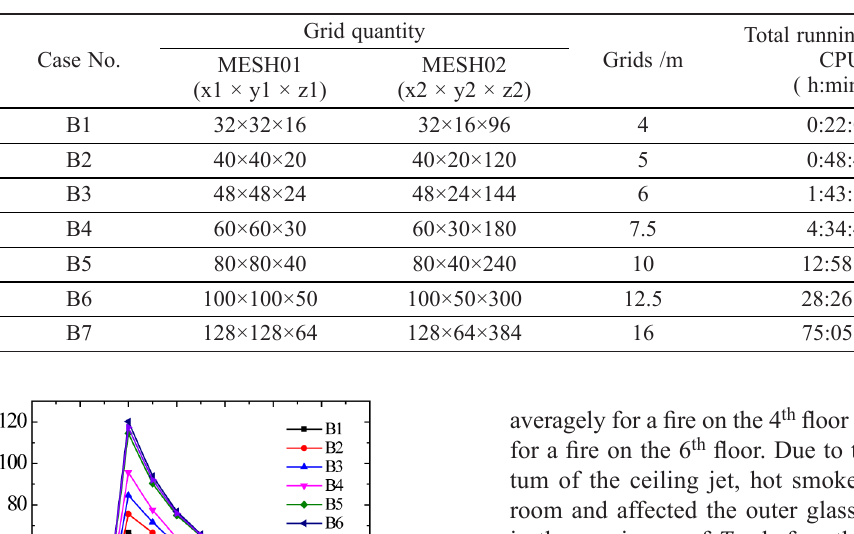
Table 2. Computing details of FDS simulation for mesh sensitivity analysis